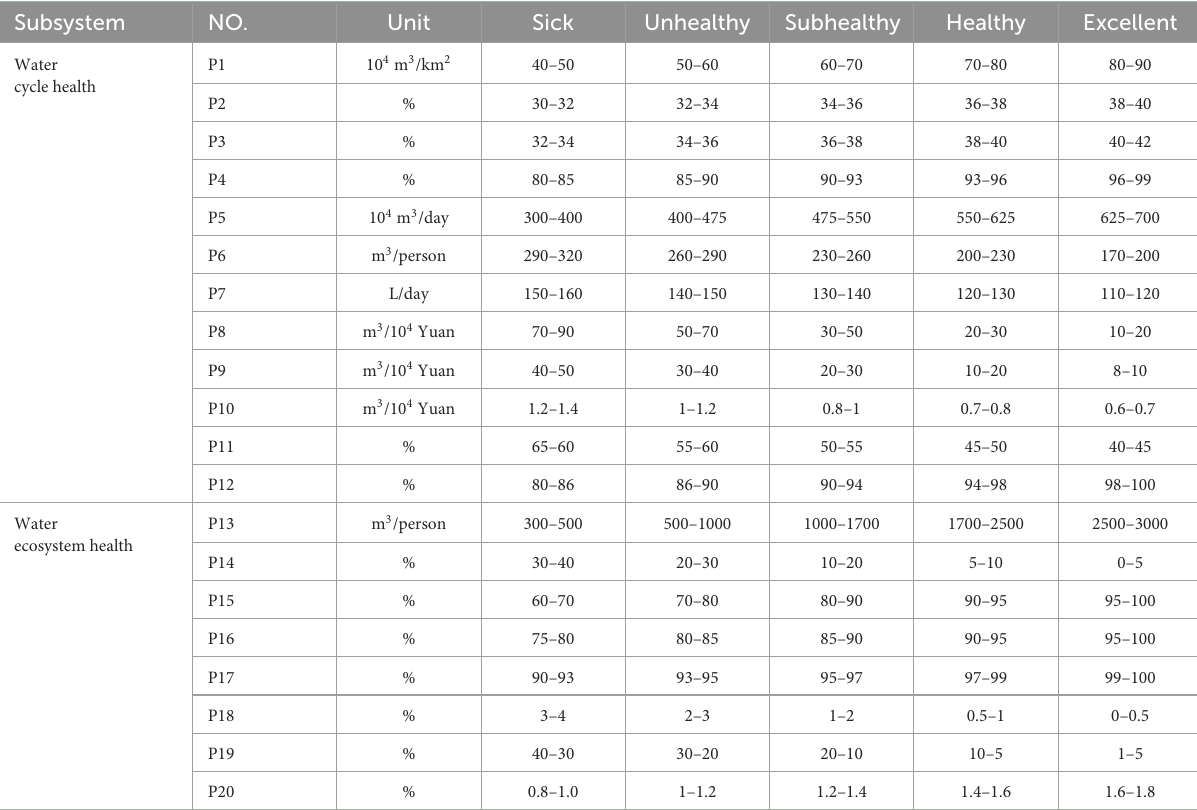
TABLE 2 Standard thresholds of each